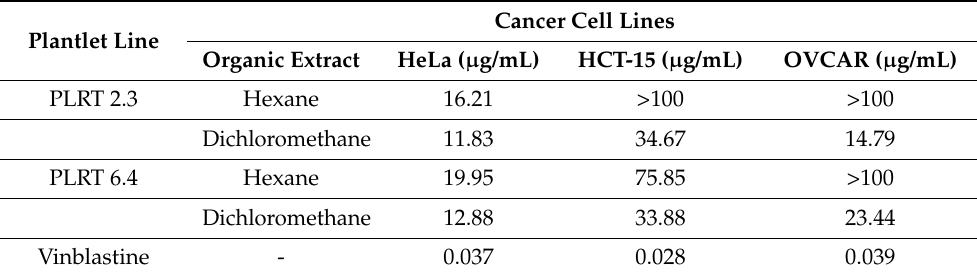
Table 3. Cytotoxicity of root organic extracts of plantlets (IC 50 ) derived from hairy root lines LRT 2.3 and LRT 6.4 of L. racemosa . Positive control: Vinblastine. Plantlet